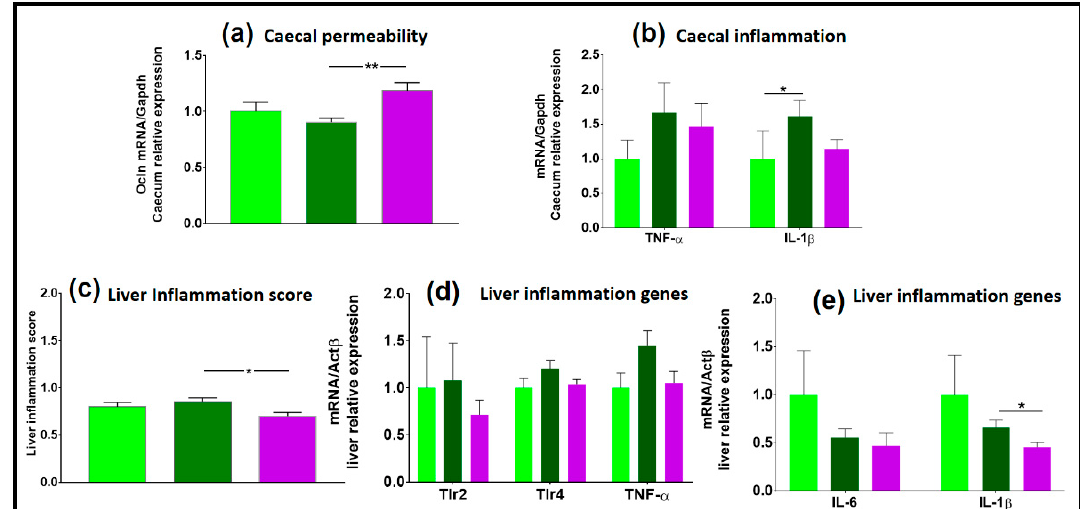
Figure 7. Gene expression in the caecum and in the liver, n = 12 mice/group. ( a ) Caecal permeability; ( b ) caecal inflammation; ( c ) liver inflammation score; ( d , e ) liver genes involved in inflammation. HR, healthy human microbiota receiver mice; CD, control diet; 2HFD, high-fructose, high-fat diet; NAFLR, NAFL patient microbiota receiver mice; light green, HR_CD, HR mice on CD; dark green, HR_2HFD, HR mice on 2HFD; purple, NAFLR_2HFD, NAFLR mice on 2HFD; (* p < 0.05, ** p < 0.01) were used for statistical comparisons.